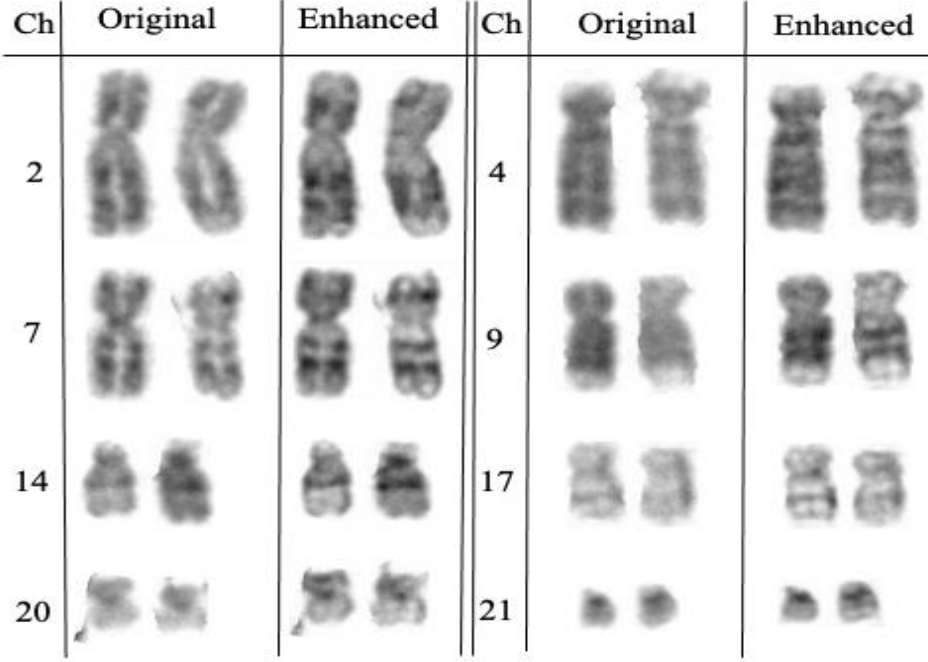
Figure 3. Examples of enhancing the paired chromosomes.